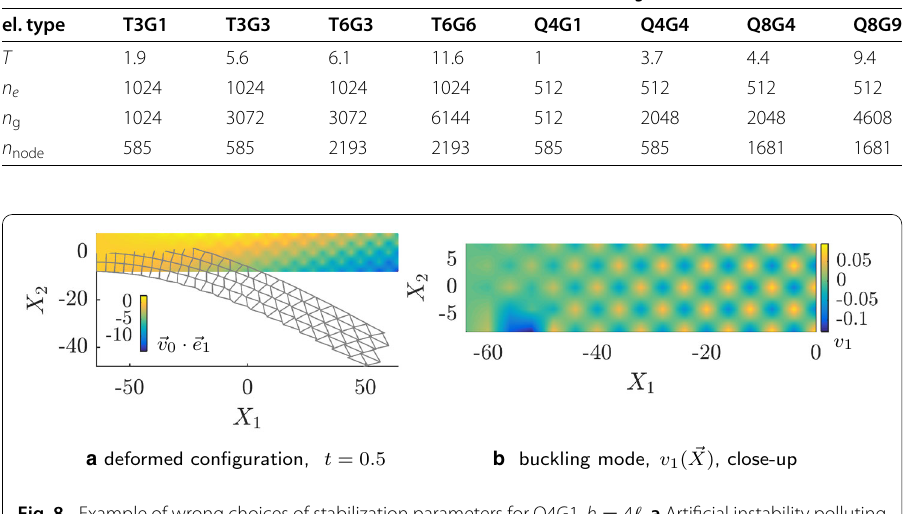
Fig. 8 Example of wrong choices of stabilization parameters for Q4G1, h = 4 (cid:20) . a Artificial instability polluting the mean field (cid:2) v 0 ; deformed configuration at t = 0 . 5 obtained for α 1 = α 2 = 0, where colour plot shows (cid:2) v 0 · (cid:2) e 1 . b Artificial instability in the micromorphic field polluting a buckling mode obtained for β 1 = 0. Recall the structure of K stab in Eq.